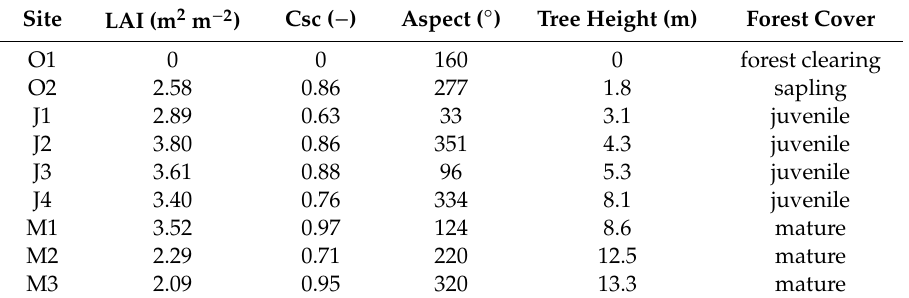
Table 1. General forest characteristics of the study sites, where LAI is the leaf area index and Csc is the canopy density (1 is a closed canopy and 0 is an open